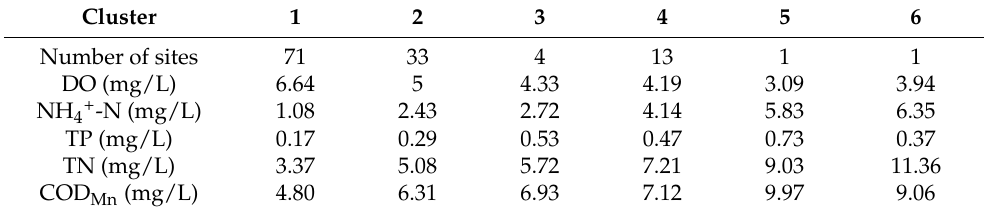
Table 4. Site numbers and mean parameter concentrations of different